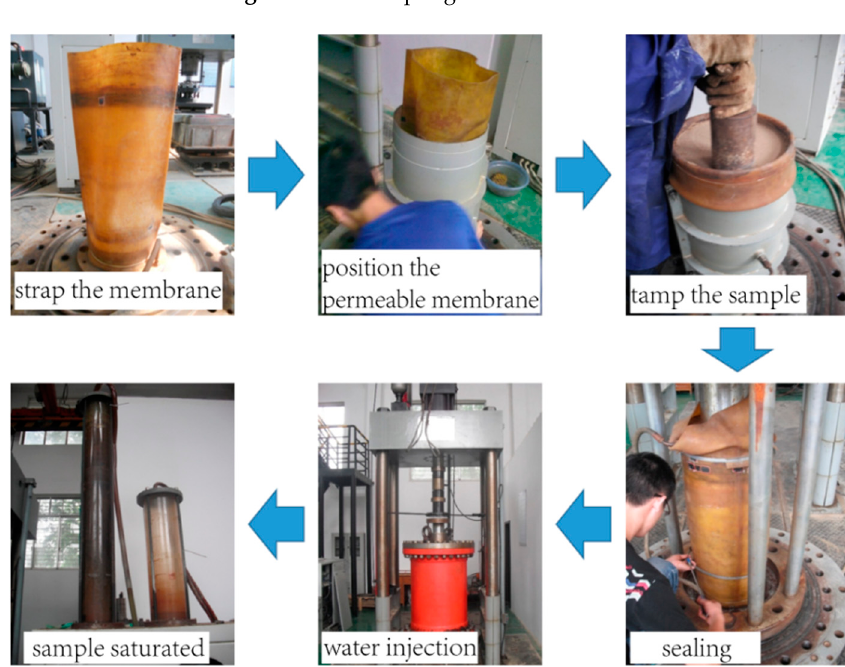
Figure 2. The triaxial test procedure.